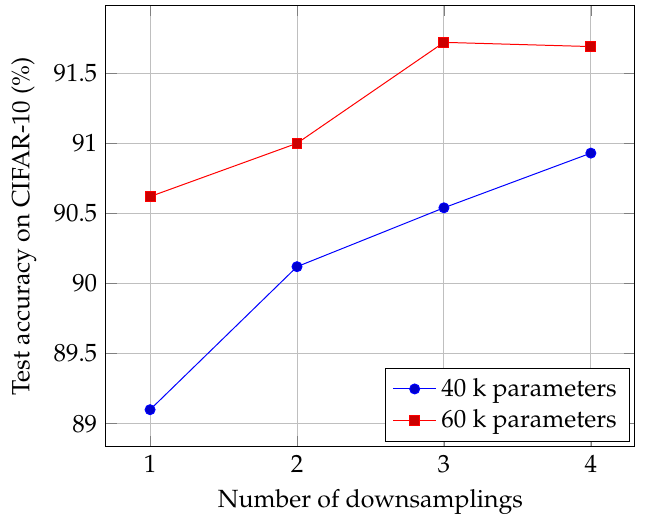
Figure 6. Accuracy on CIFAR-10 as function of the number of downsamplings. We performed 30, and downsamplings are evenly spaced, with a global max pooling at the very end.